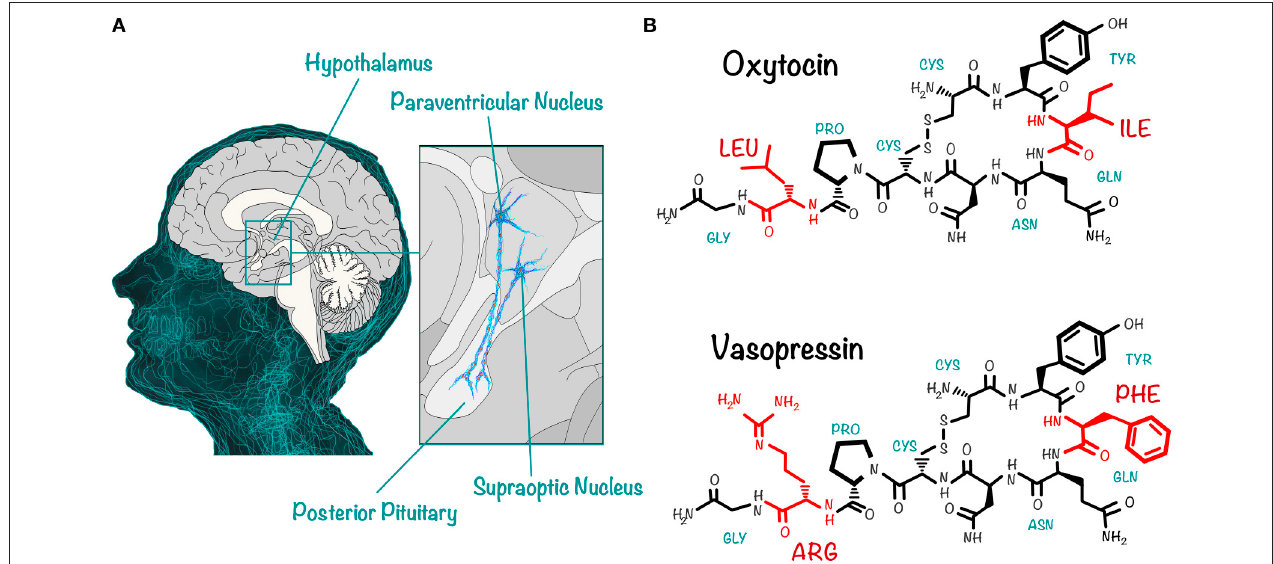
FIGURE 1 | OXT and AVP are two closely related nonapeptides that exert their action on central and peripheral targets. (A) OXT and AVP are synthesized in the PVN and the SON of the hypothalamus. The peptidergic neurons in these nuclei project axons to the posterior pituitary, from where the peptides are released into the circulation. They act as hormones on peripheral targets, having well-documented actions (uterine contraction and vasoconstriction, for instance). In addition, dendrites of neurons in the PVN and the SON release the peptides directly into the brain, where they act as neurotransmitters or neuromodulators, regulating complex social cognition and behaviors. (B) OXT and AVP differ in only two aminoacids: this schematic drawing shows that, whereas the aminoacid sequence of OXT (top) includes an isoleucine at the third and a leucine at the eighth position, that of AVP (bottom) includes a phenylalanine and an arginine in the corresponding positions. Both peptides contain a cyclic six aminoacid ring, because of the disulfide bond formed by two cysteine